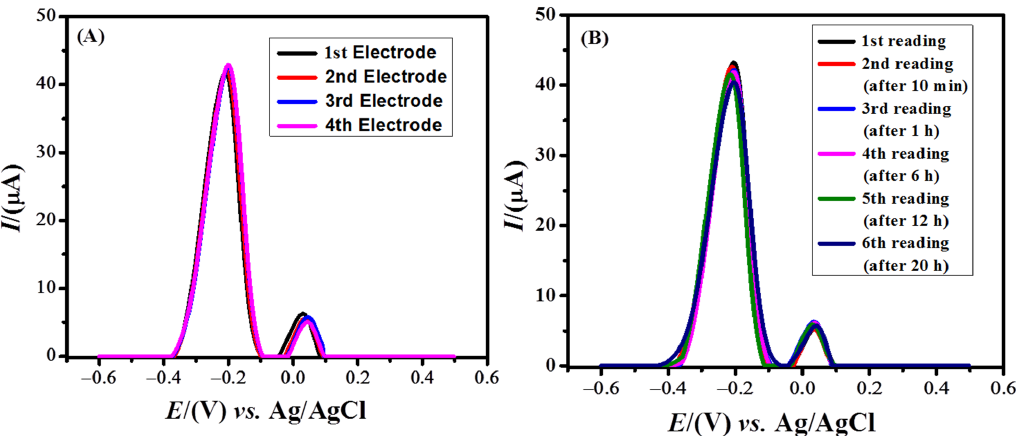
Figure 7. ( A ) Square wave voltammograms of MB showing the reproducibility and ( B ) SWV of MB showing repeatability of the developed sensor in PBS of pH of 6.